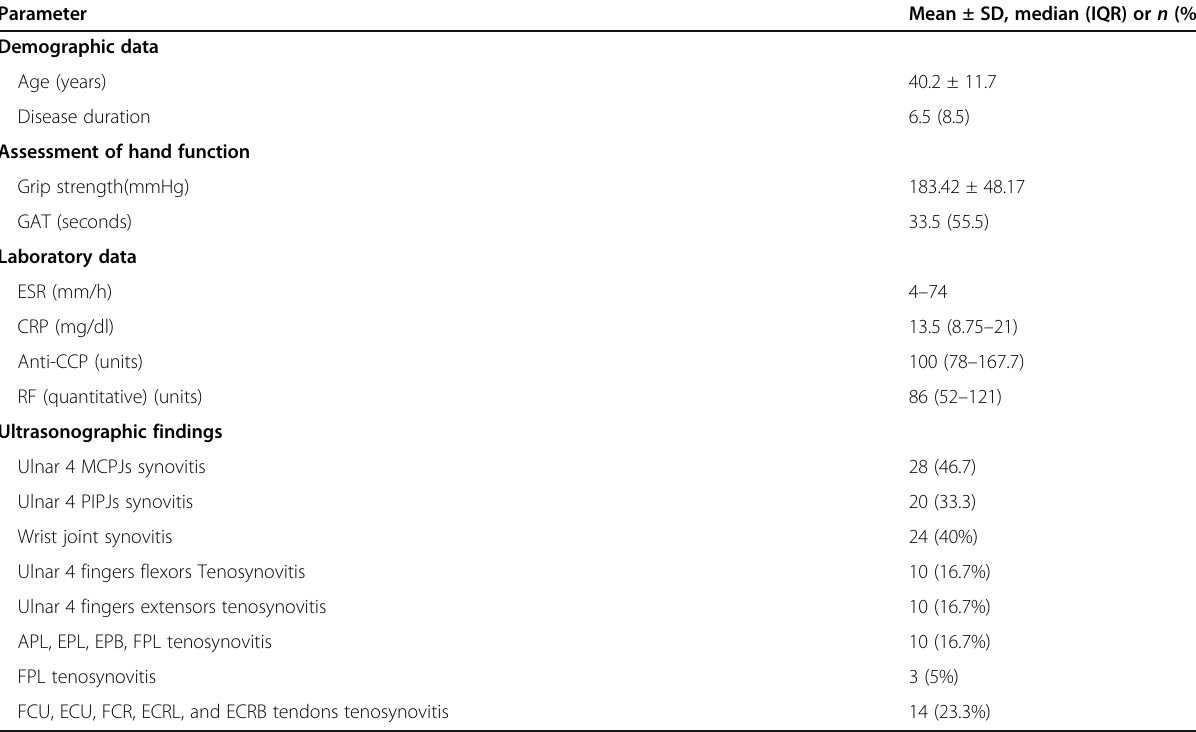
Table 1 Demographic, clinical, and laboratory features of the rheumatoid arthritis patients